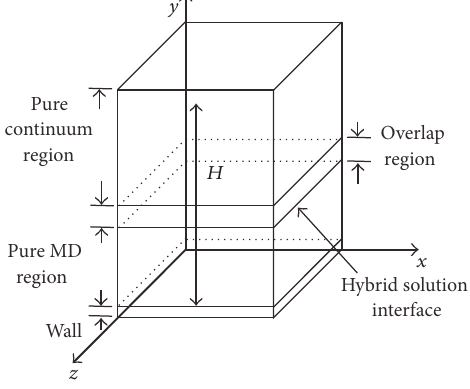
Figure 2: Simulation domain decomposition and coordinates of the slip boundary condition; 𝐻 is the height of the